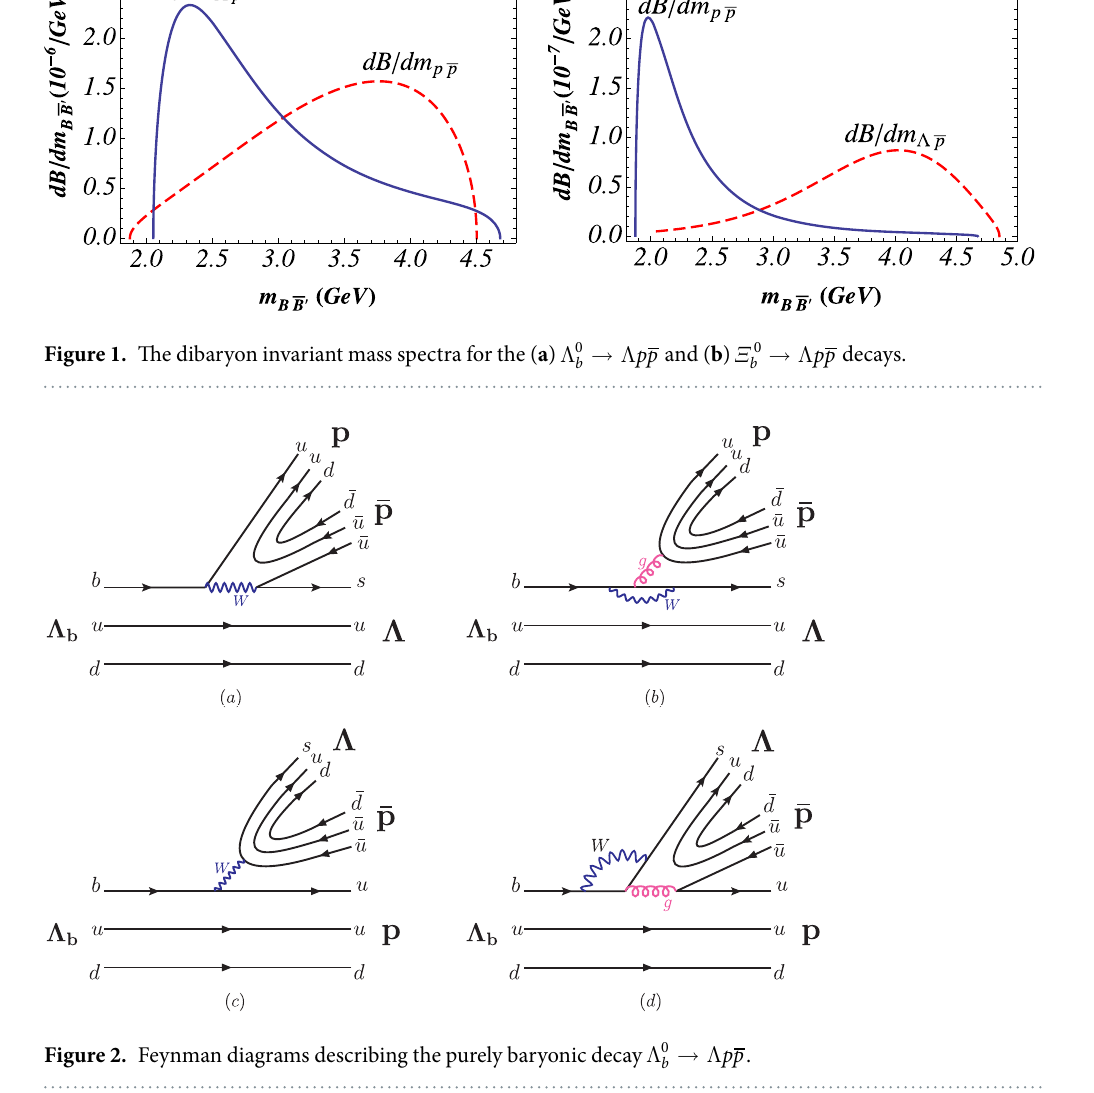
Figure 2. Feynman diagrams describing the purely baryonic decay Λ → Λ pp